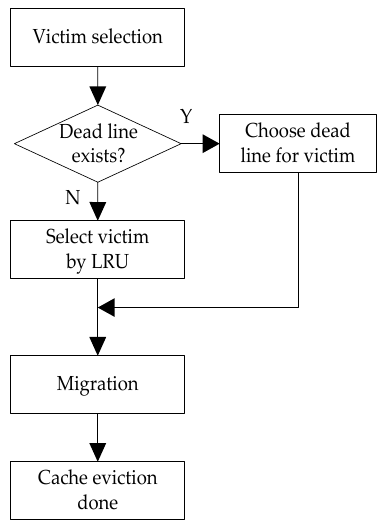
Figure 4. The optimization in cache eviction.